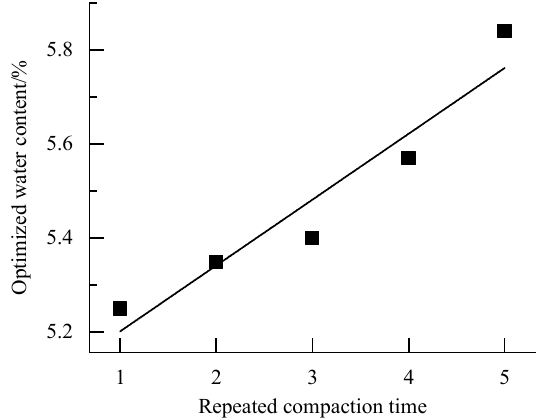
Figure 7. Distribution of optimized water content against the repeated compaction